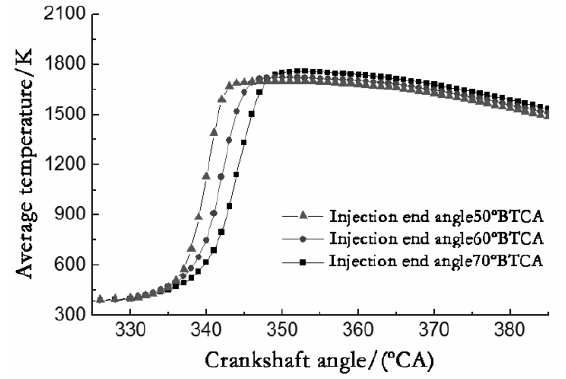
Figure 9. Average temperature in the cylinder at different injection end angles.